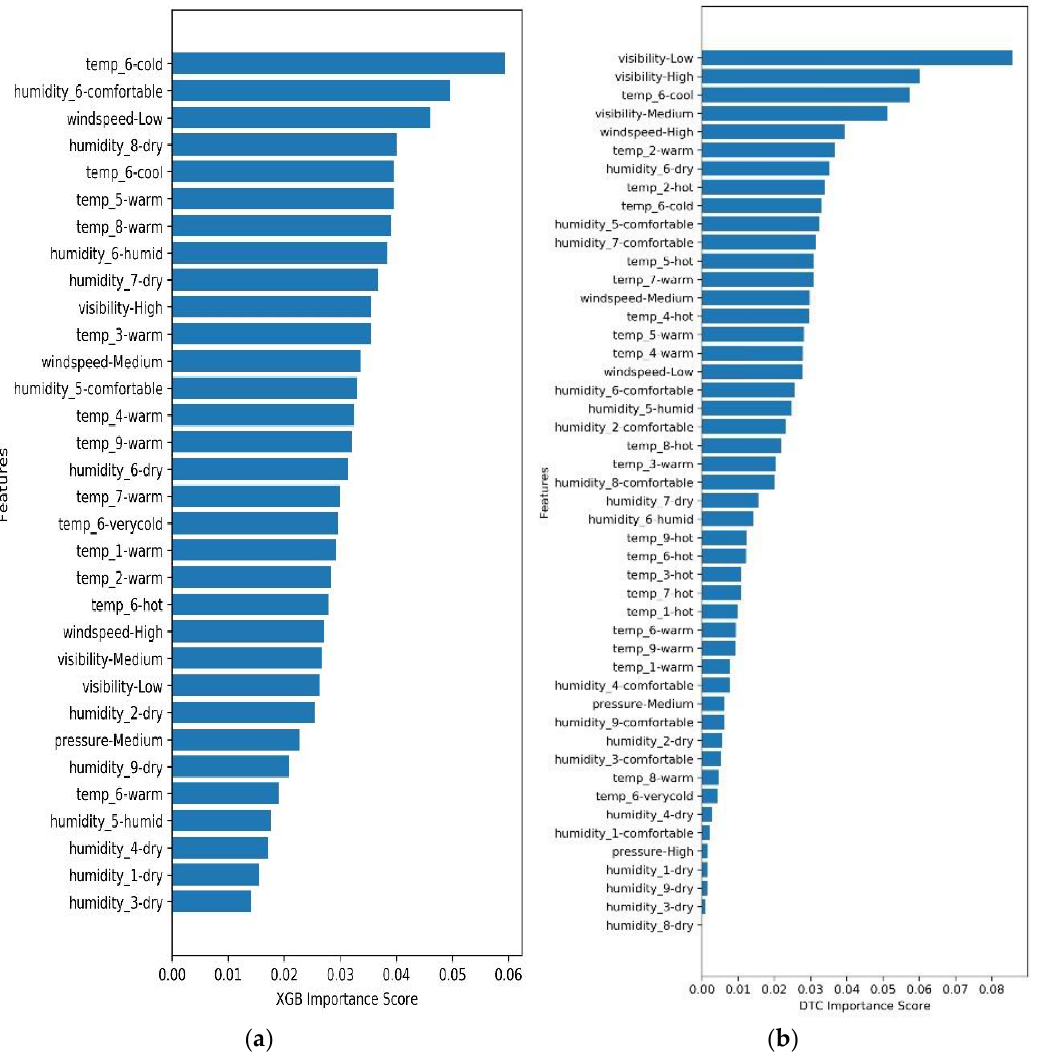
Figure 6. Importance scores of state-based features. ( a ) XGBoost feature importance, showing the importance of a feature on the performance of a trained model using this algorithm; ( b ) Decision Tree Classifier feature importance, showing the normalized total reduction of the criterion brought by that feature. More important features receive higher scores.